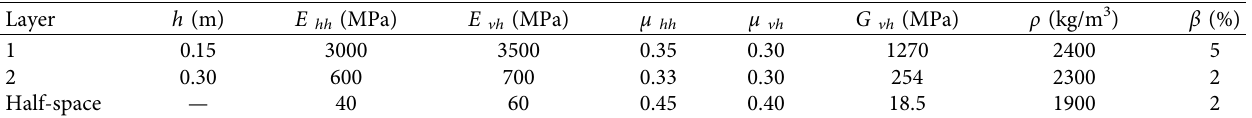
Figure 7: Te vertical displacement of the medium calculated by imperfect interface models I, II, and III at a fxed surface point, i.e., ( x , y , z ) � (0.5, 0, 0): (a) as a function of the dimensionless distance at a fxed dimensionless frequency of one ( ω 0 � 1); (b) as a function of the dimensionless frequency. Table 2: Te material properties of the layers of the crossanisotropic layered medium.